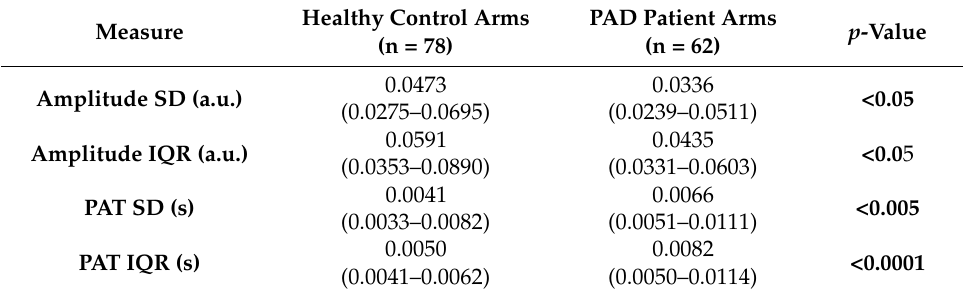
Table 5. Time-domain variability results in the fingers comparing PAD and healthy control groups. Median (IQR) values are shown. a.u.: Arbitrary